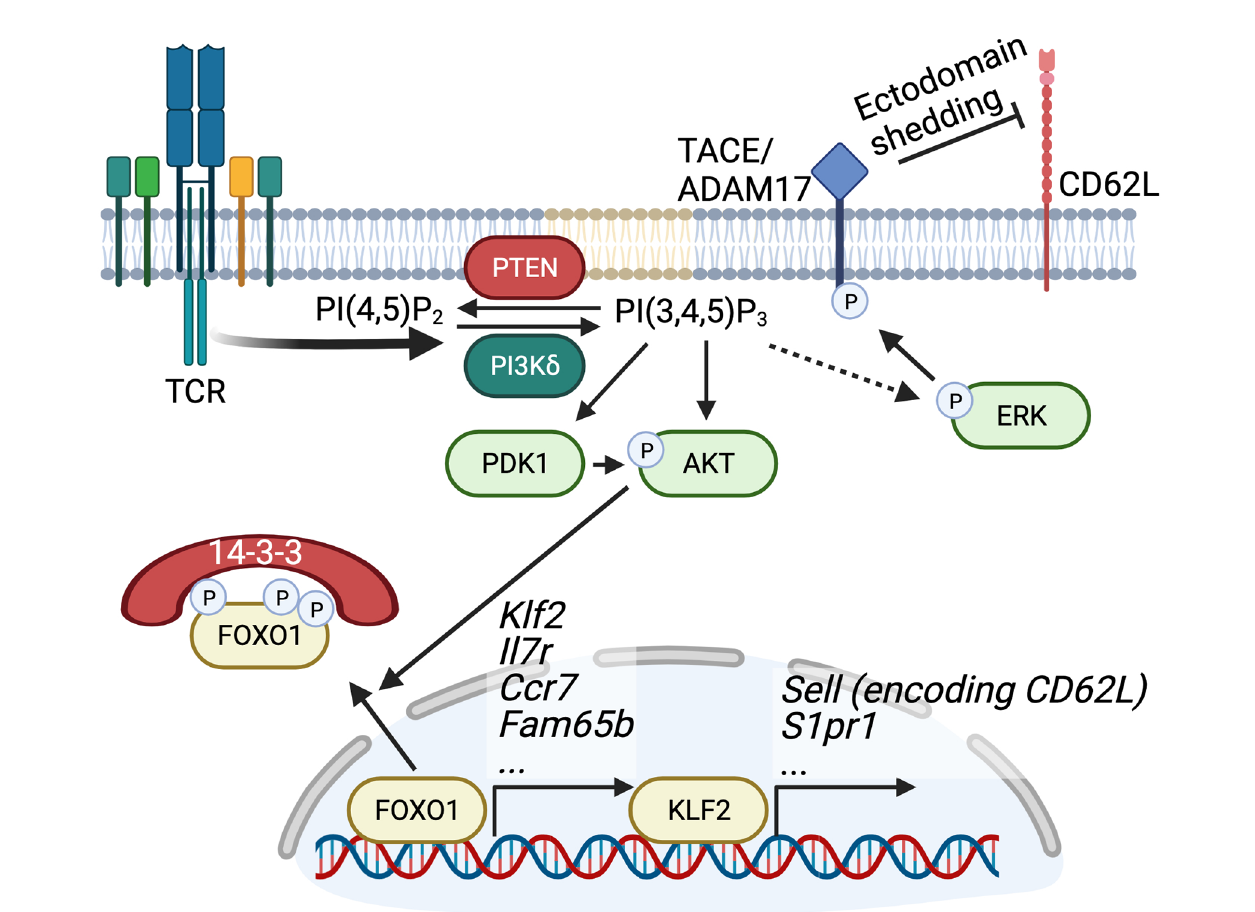
FIGURE 5 | PI3K d -mediated regulation of CD62L, CCR7, and S1PR1. PI3K-mediated PIP 3 production leads to recruitment of PDK1 and AKT, leading to AKT activation. AKT phosphorylates FOXO1, which allows for binding of the 14-3-3 leading to cytosolic sequestration of FOXO1. FOXO1 promotes transcription of Klf2 (as well as Il7r , Ccr7, Fam65b ). Decreased expression of the transcription factor KLF2 in turn results in decreased transcription of the CD62L encoding gene Sell and S1pr1 . Figure made in